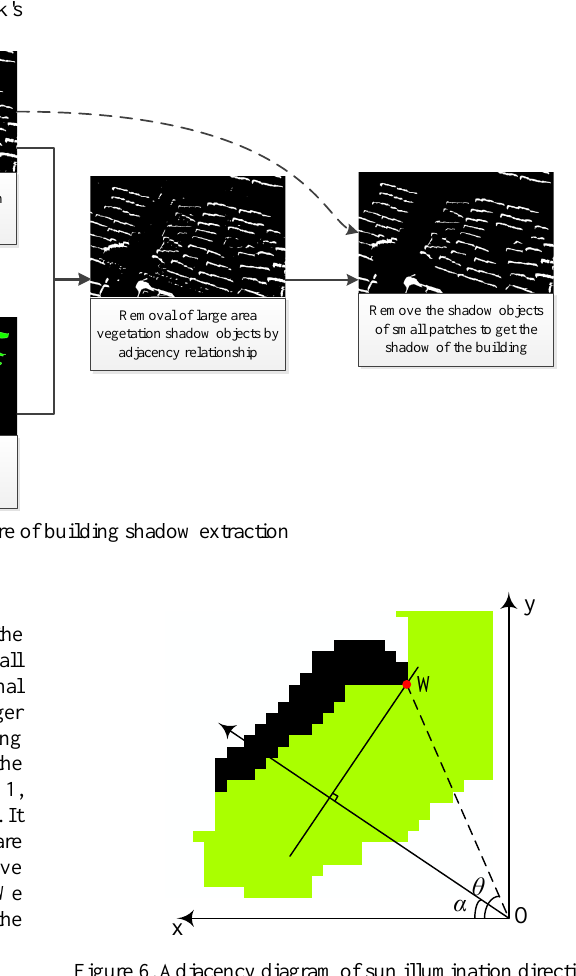
Figure 6. Adjacency diagram of sun illumination direction and adjacent